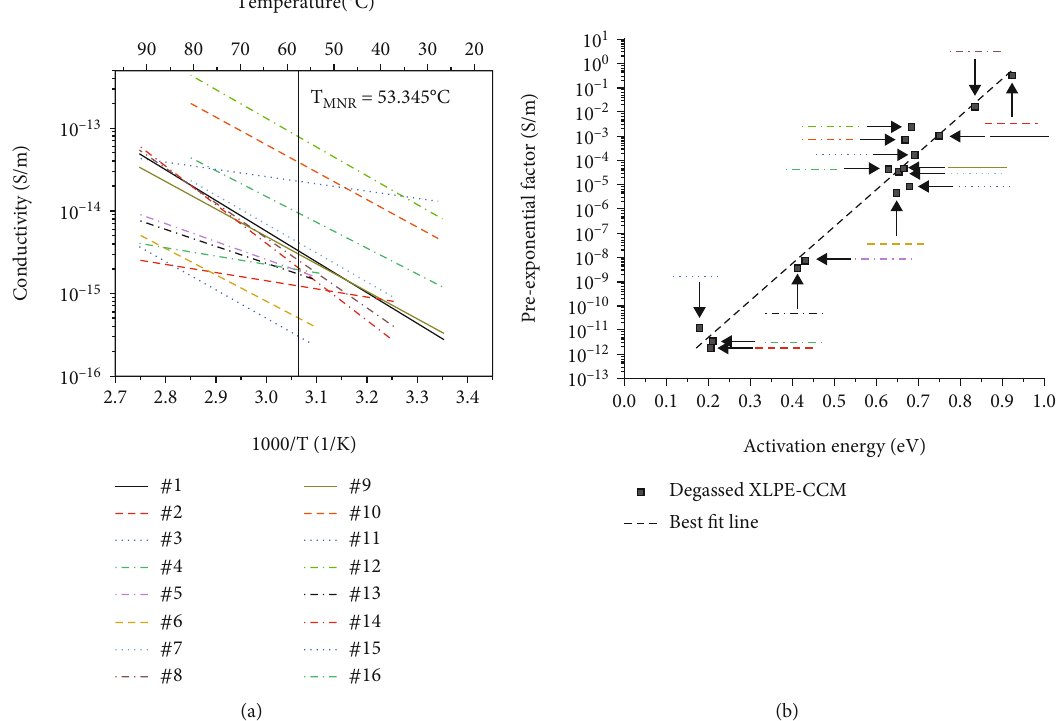
Figure 1: (a) Conductivity vs. temperature plot and (b) compensation law plot for degassed XLPE samples. Crosslinking was achieved via melt pressing at a speci fi c temperature (TXL) with a speci fi c concentration of DCP for 12 minutes. All samples were degassed in a vacuum oven at 65 ° C for 72 hours. Sample parameters are as follows: #1-2.12% DCP, TXL = 160 ° C ; #2-2.12% DCP, TXL = 140 ° C ; #3-2.12% DCP, TXL = 120 ° C ; #4 to #6-2.14% DCP, TXL = 180 ° C ; #7 to #12-2.3% DCP, TXL = 180 ° C ; #13-3.2% DCP, TXL = 180 ° C ; #14-4.9% DCP, TXL = 180 ° C ; #15-6.7% DCP, TXL = 180 ° C ; and #16-10% DCP, TXL = 180 ° C .